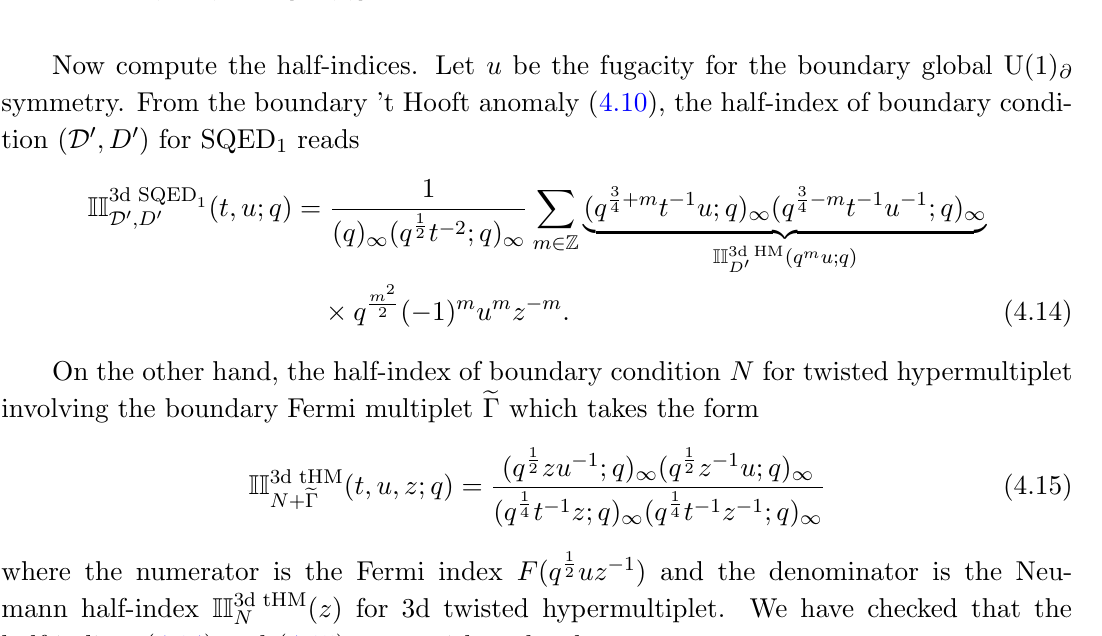
Figure 8 . The brane constructions of the Neumann b.c. ( Dirichlet b.c. (